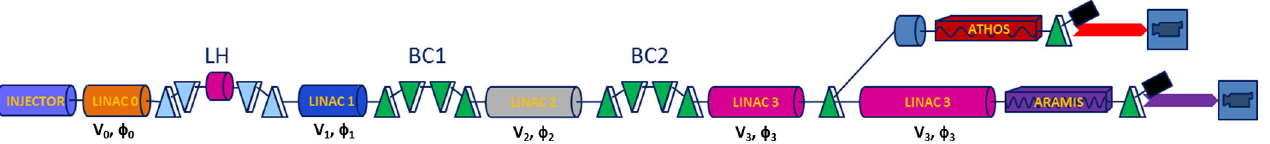
and the phases ϕ along the different sections in the machine used i i